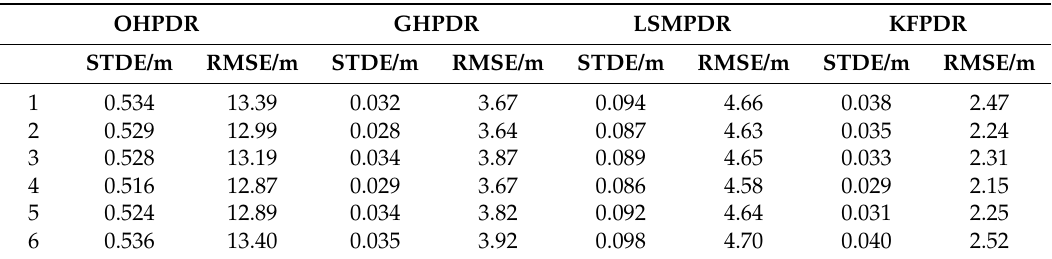
Table 5. Positioning analysis for different solutions associated with PDR in C-B area on the 5th floor.